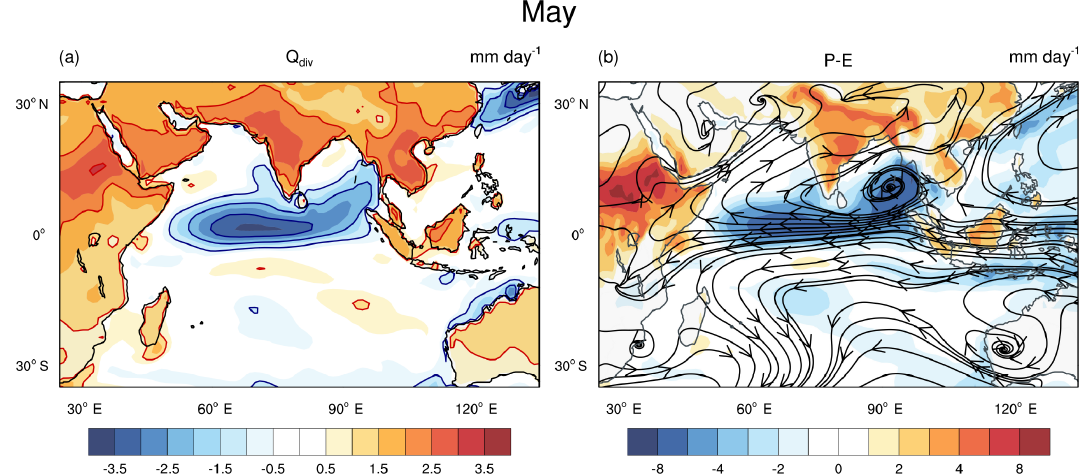
Figure 10. The difference between P min and P max in (a) , Q div and (b) , P − E along with streamlines of change in the wind, for the month of May. Note that the large increase in Q div over Africa leads to an early onset of African monsoon. Thus, influencing the winds over the equatorial Indian